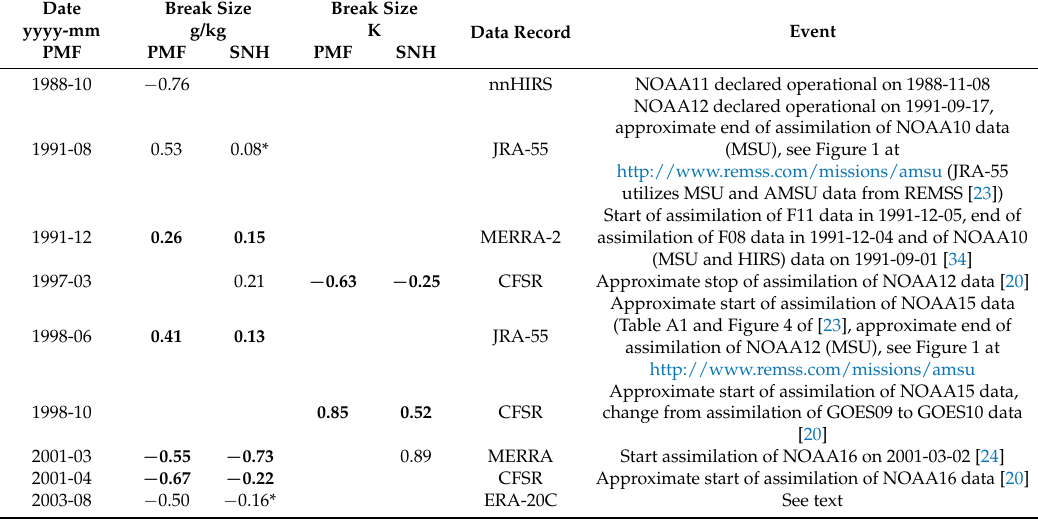
Table 4. Dates of observed break points, break sizes from the PMF test, and coincident changes in the observing system or changes of the input to the assimilation schemes based on the analysis of q and T anomaly differences relative to ERA-Interim for the region Sc Pacific (700 hPa) (extended and updated from [3]). Additionally, the break size from the SNH test is given when within a range of ± 3 month of the date of the break point from the PMF test. Break sizes from the SNH test marked with an asterisk are not significant. The break size is printed in bold when the results from both homogeneity tests are significant.